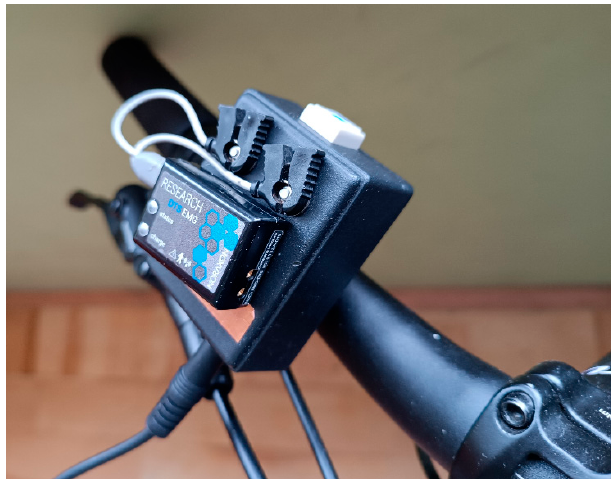
Figure 4. DTS EMG sensor with intermediary circuit–adopted Digital System for Determining Foot Contact with the Ground, Patent PL 222753.B1 (author’s material).